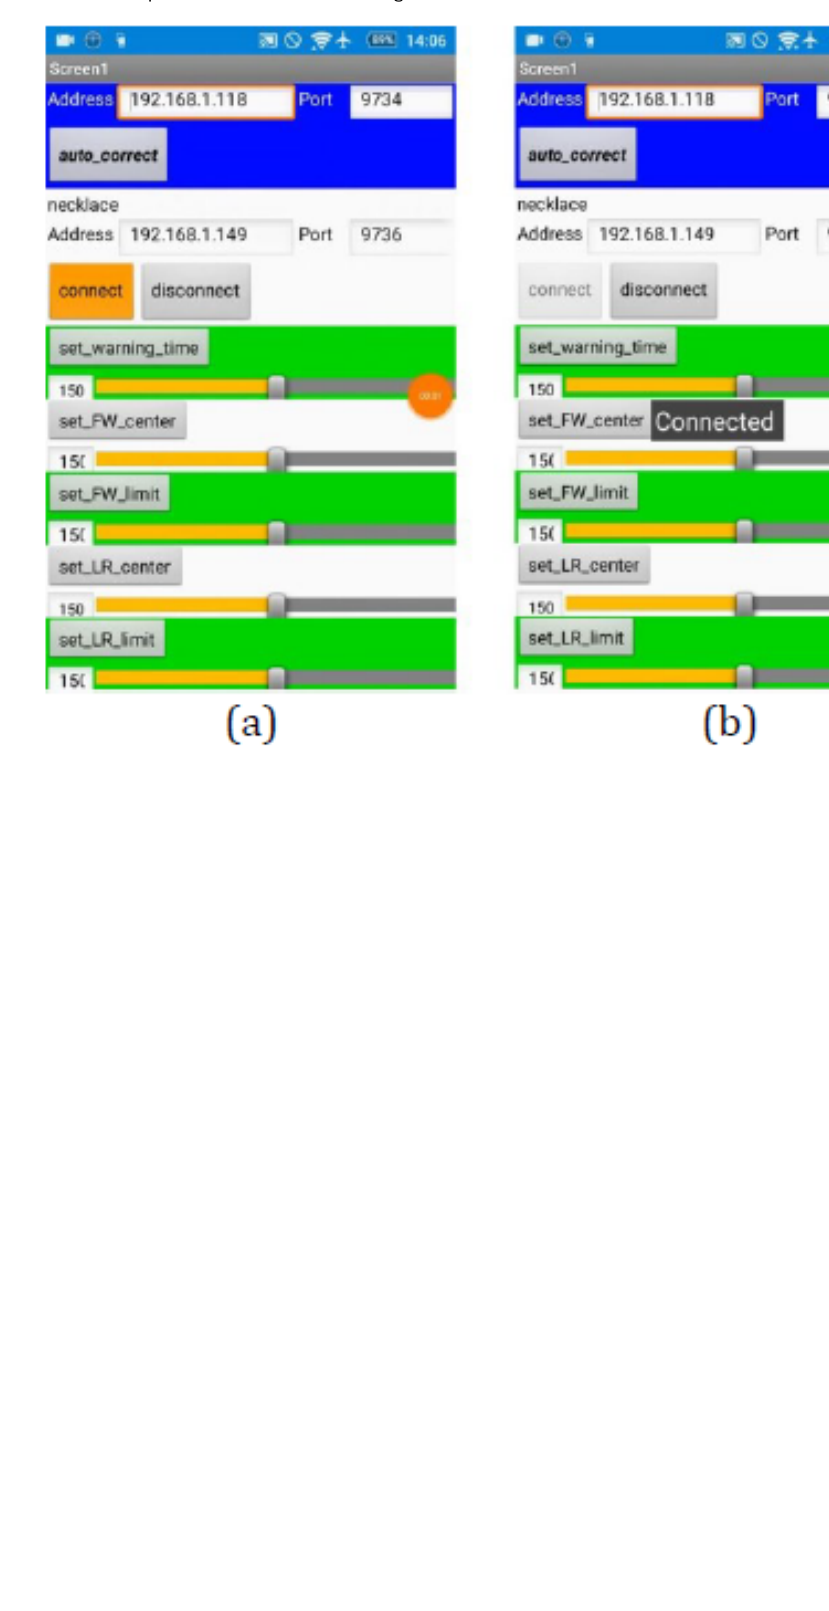
Figure 20. Activation of the smartphone’s function for receiving reminders from the smart